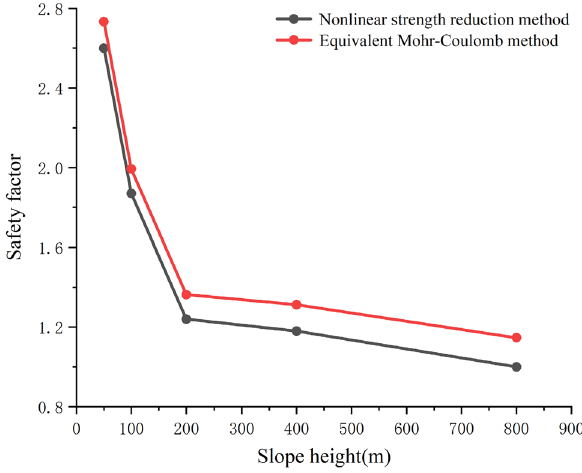
Figure 10. Relation curve between slope height and safety factor.